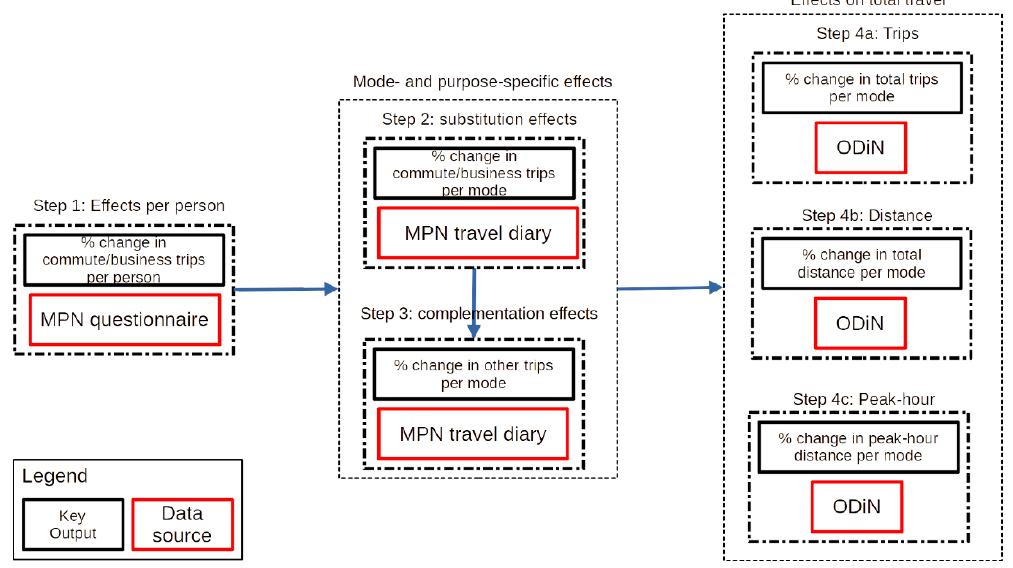
Figure 3. Structure of the analysis resulting in estimated effects on